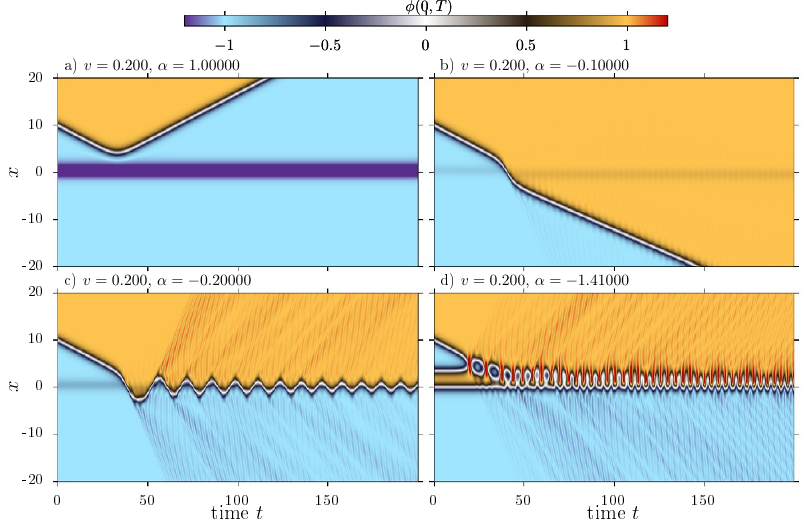
Figure 20 . Di(cid:11)erent scenarios of kink-impurity ((cid:6) (cid:0) + K ) collisions for v = 0 : 2. The parameter values are a) (cid:11) = 1, b) (cid:11) = (cid:0) 0 : 1, c) (cid:11) = (cid:0) 0 : 2 and d) (cid:11) = (cid:0) 1 : 41.